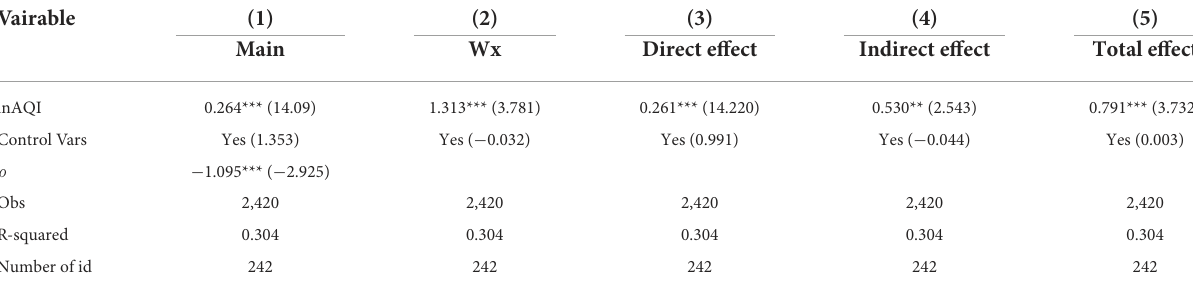
TABLE 10 Impact of atmospheric quality improvement on enterprise productivity—LP. Vairable